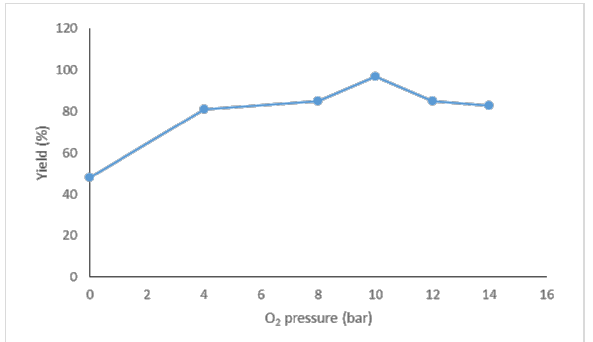
Figure 2: Observed trend for the effect of changing oxygen pressure on the NMR yield of 19